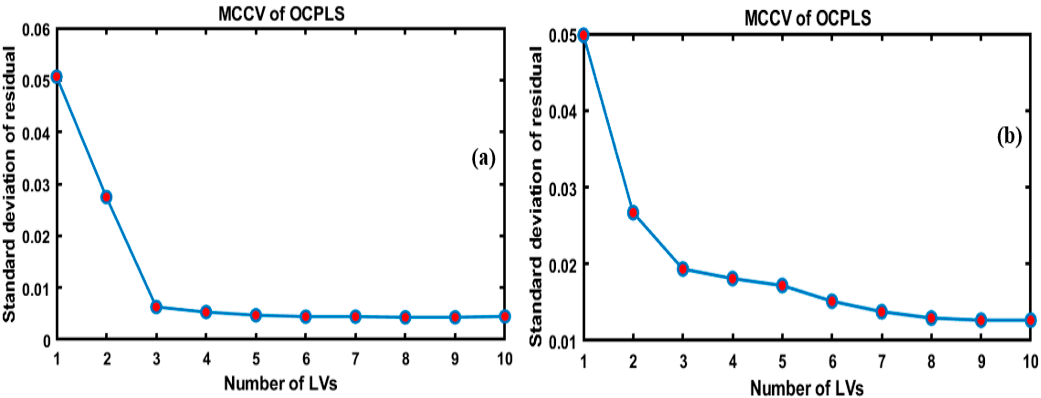
Figure 3. Standard deviation of residuals of one-class partial least squares (OCPLS) modeling vs. the number of latent variables in Monte Carlo cross-validation (MCCV) of OCPLS based on the FT-IR ( a ) and FT-NIR ( b ).